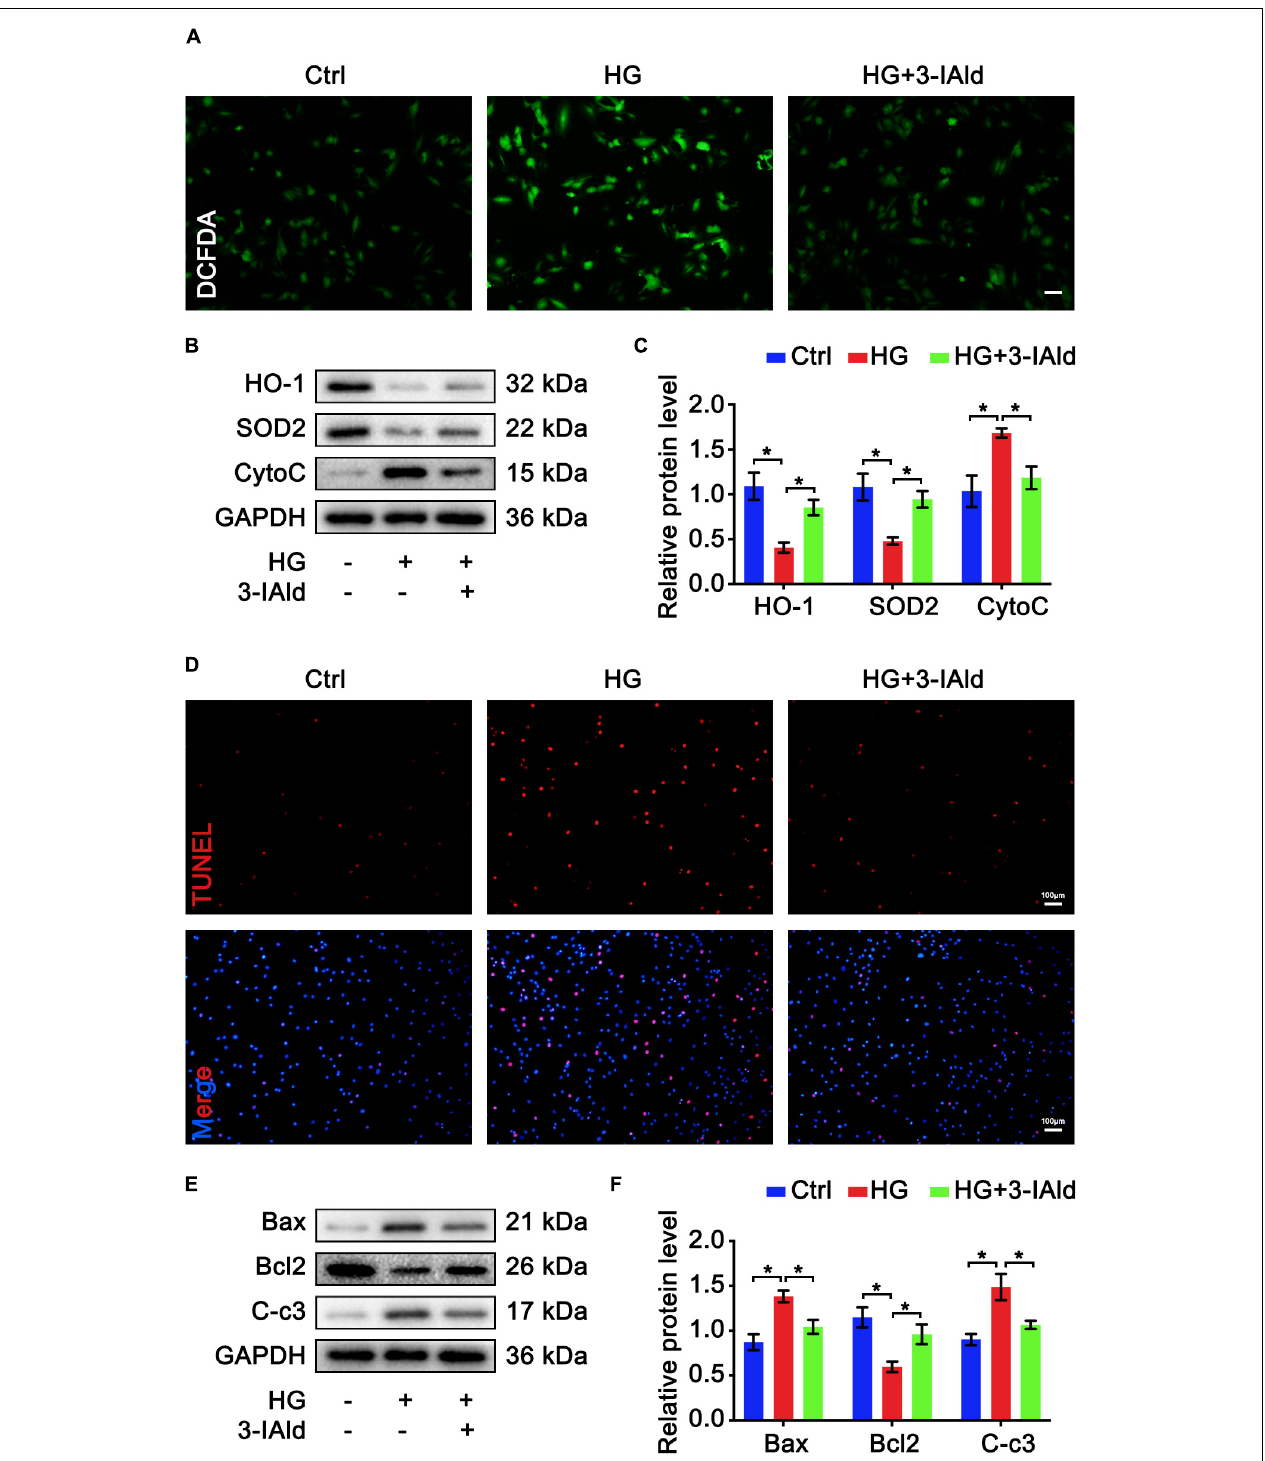
FIGURE 4 | 3-IAld protects ECs from HG-induced oxidative stress and apoptosis. (A) DCFDA staining in HUVECs in the control, HG and HG + 3-IAId groups; scale bar: 50 µ m. (B) Western blot analysis of oxidative stress-related molecules in HUVECs in the control, HG and HG + 3-IAId groups. (C) Quantification of relative protein levels; n = 6 for each group. (D) TUNEL staining in HUVECs in the control, HG and HG + 3-IAId groups; scale bar: 100 µ m. (E) Western blot analysis of apoptosis-related molecules in HUVECs in the control, HG and HG + 3-IAId groups. (F) Quantification of relative protein levels; n = 6 for each group. Data are presented as the mean ± SEM. * P <